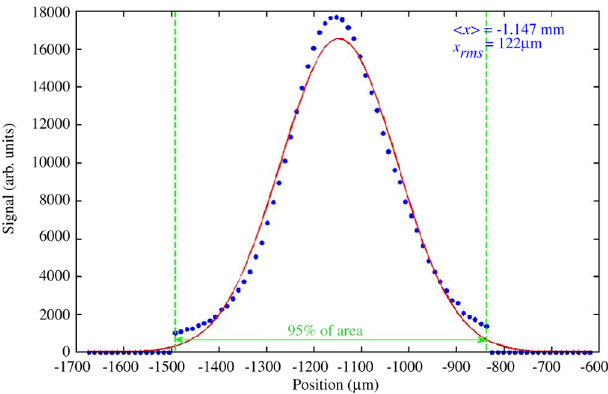
FIG. 26. (Color) Example measured horizontal beam profile (cid:3) 122 (cid:2) m ) from OTR screen at 135 MeV with ‘‘5% ( (cid:3) x area-cut’’ applied, eliminating the tails. (A red Gaussian curve with the same rms is overlaid simply for